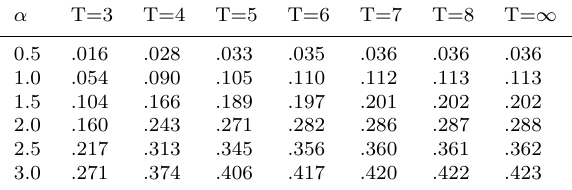
Table 4. Comparison of P T ( D = 2) with P ∞ ( D =